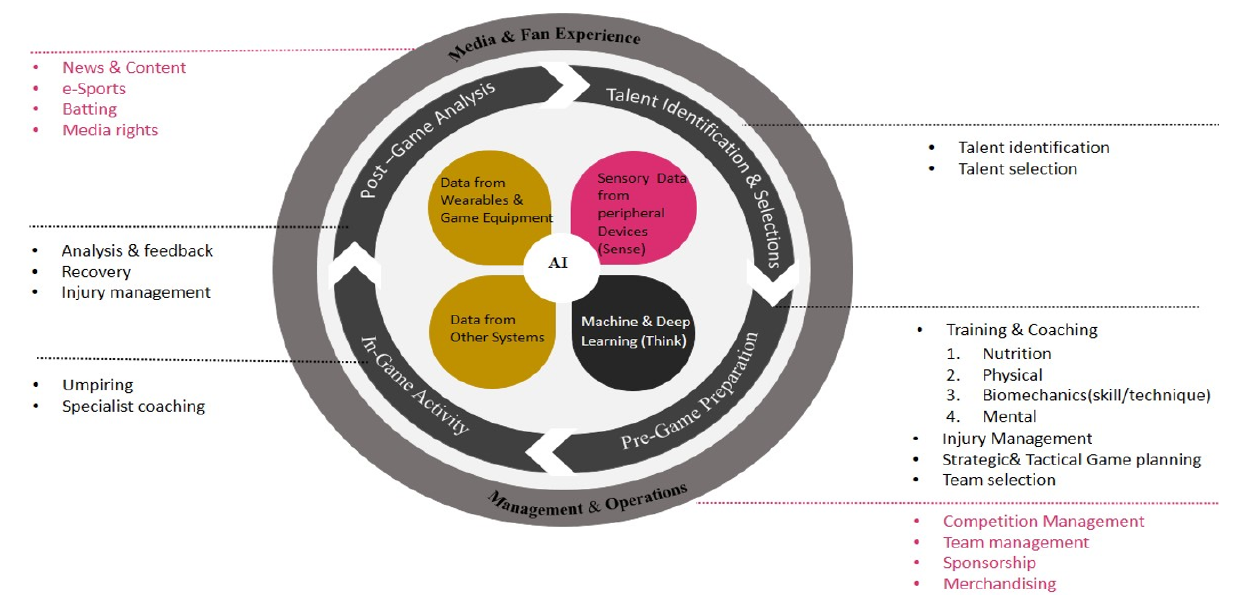
Figure 14. AI technology framework for the sport